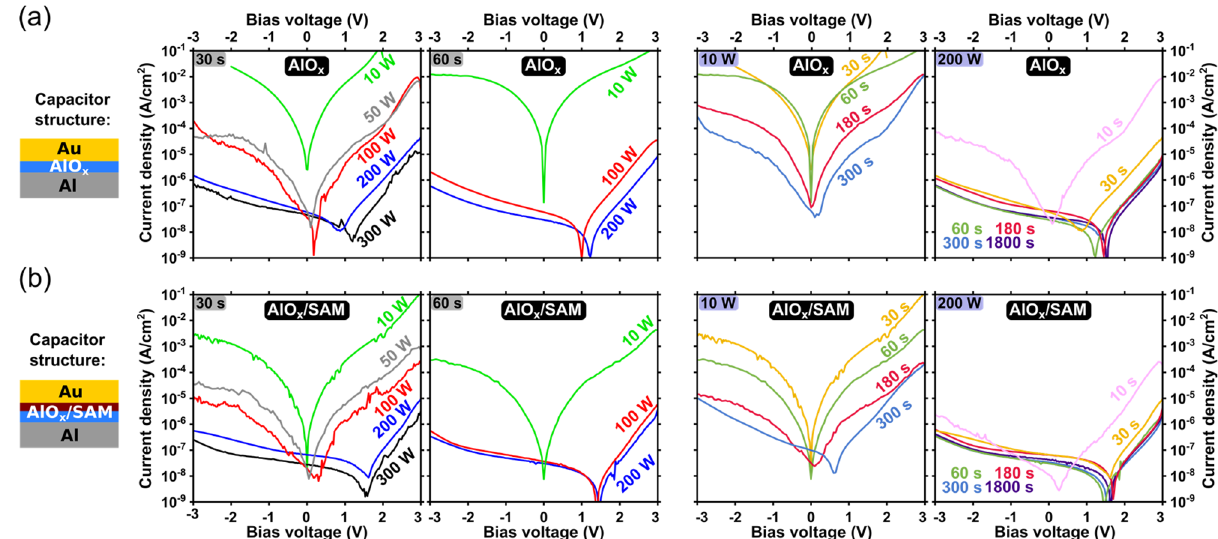
Figure 4. Current density measured as a function of applied voltage through capacitors with a bare-AlO x dielectric ( a ) and a hybrid AlO x /SAM dielectric ( b ) for various combinations of plasma power and plasma